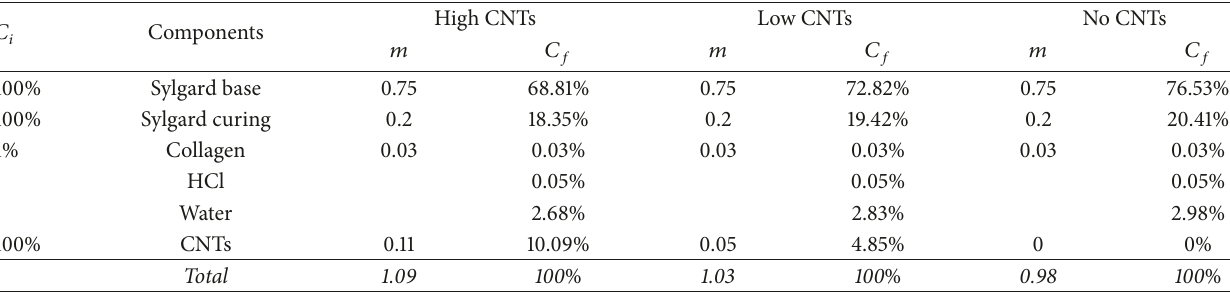
Table 1: Composition of experimental silicone-based films.